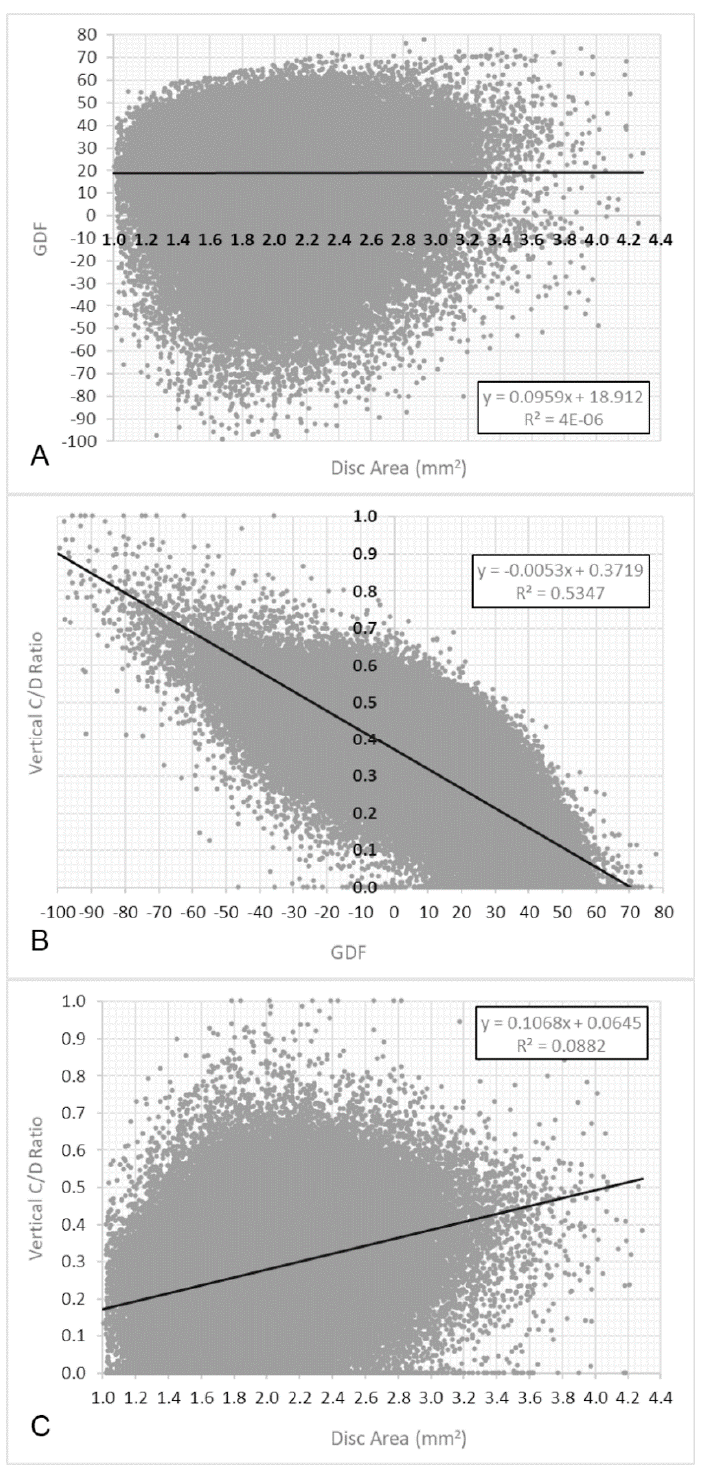
Figure 3. ( A ). Relationship between GDF and disc area values in the first control image. ( B ). Relationship between GDF and vertical C/D ratio. ( C ). Relationship between disc area and vertical C/D ratio.